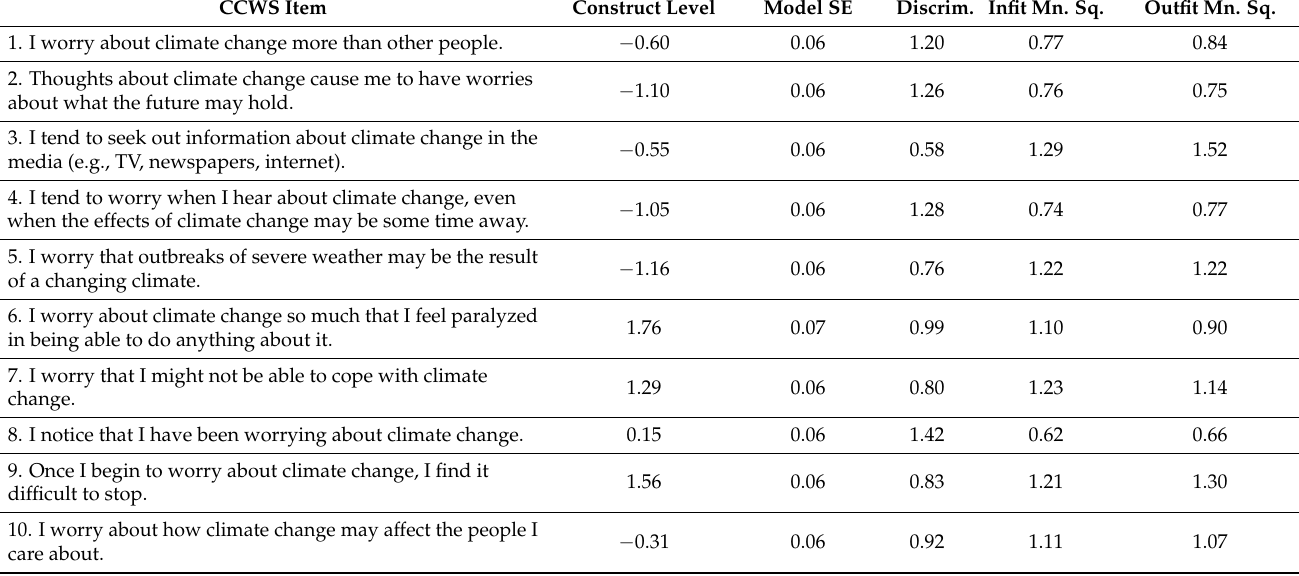
Table 6. Item characteristics and Rasch model fit